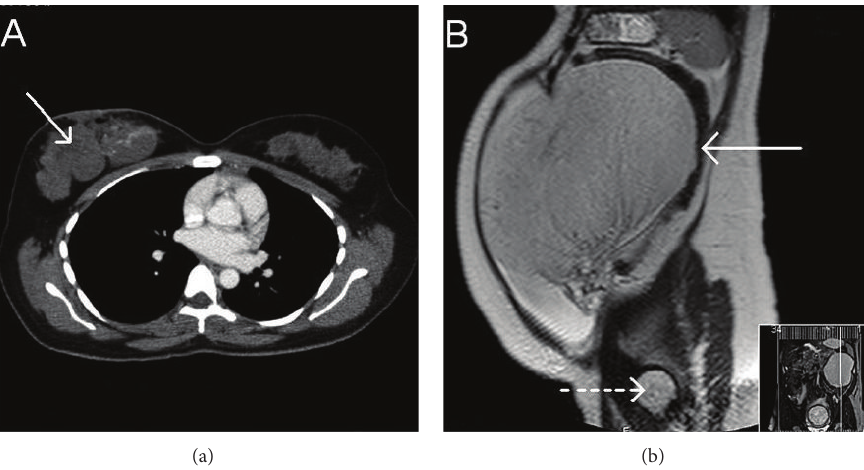
Figure 1: (a) Computed tomography (CT) scan show multifocal masses in the deep parenchyma of the right breast (arrowed); the largest measuring 4.6 cm in maximum diameter. (b) Magnetic resonance imaging (MRI) scan showed a large 19 × 17 × 8.3 cm smooth, circumscribed homogeneous solid mass in the left upper quadrant (arrowed), which was seen to displace the gravid uterine fundus to the left of the midline (dotted arrow), without mural